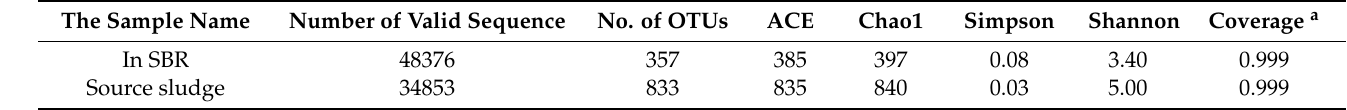
Table 4. Alpha diversity indices of the source community and acclimated